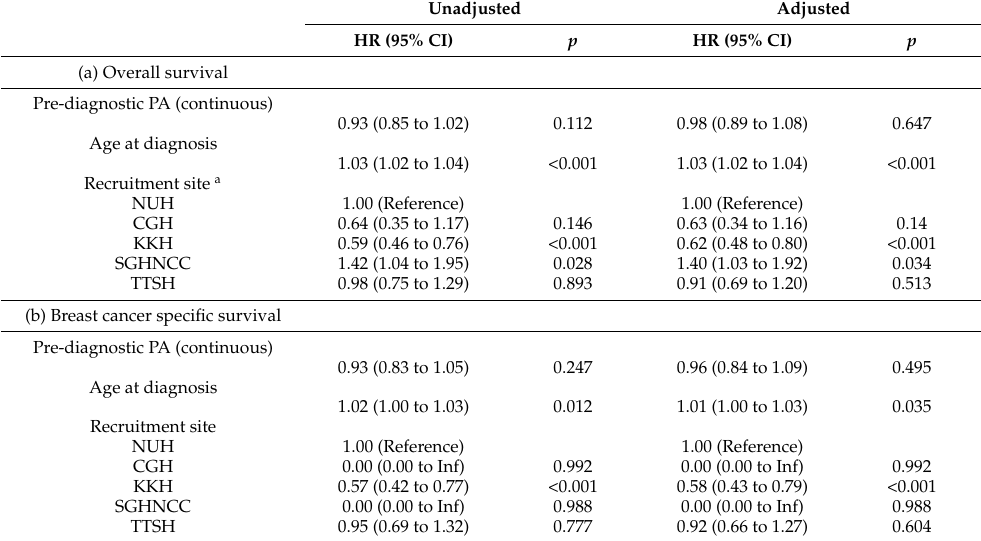
Table 3. Cox regression model showing association between pre-diagnostic physical activity (PA) score and ten-year survival, adjusted for age at diagnosis and recruitment site ( n = 6572). Hazard ratios (HR) and 95% confidence intervals (CI) were estimated using Cox regression